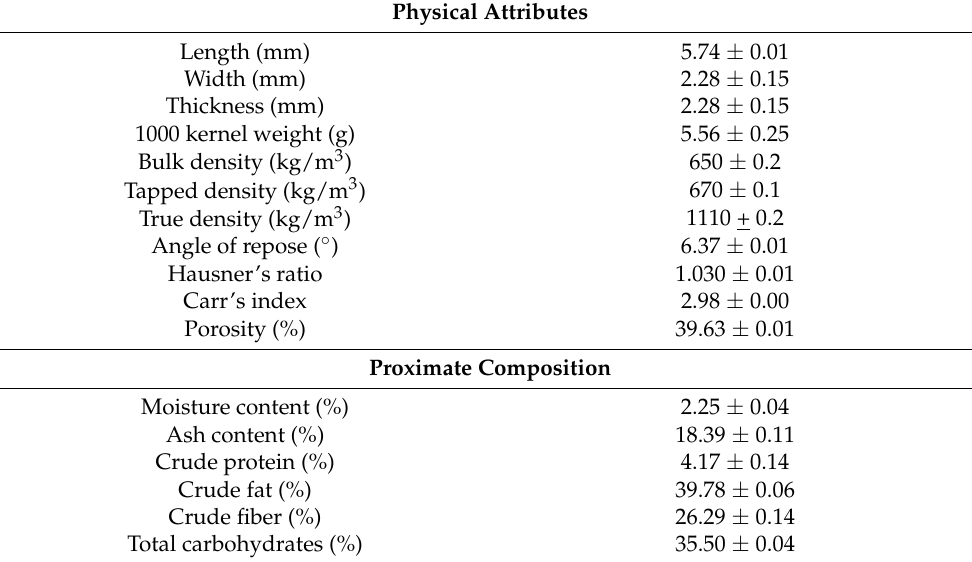
Table 2. Physical characterization and proximate composition of the